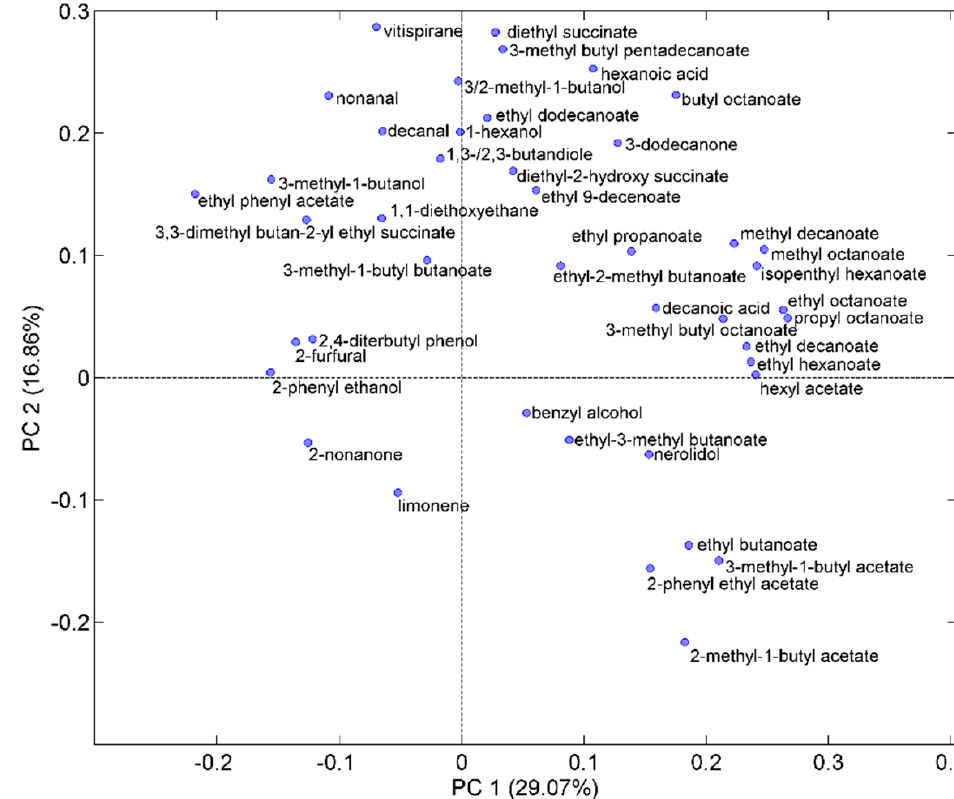
Figure 8. Projection of PEC and TRE wine samples onto the plane of the first two principal compo- nents (PC1 and PC2) extracted from the volatile profiles collected with the DVB/CAR/PDMS fiber.